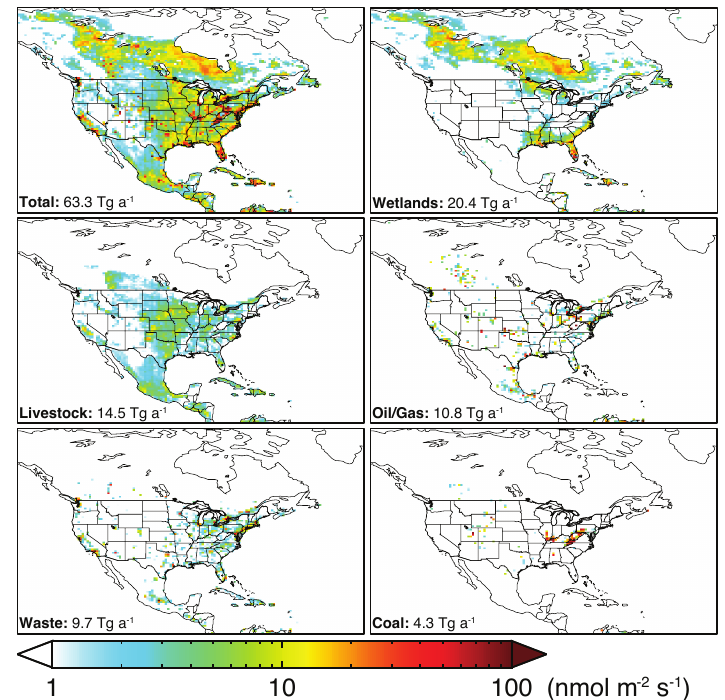
Figure A2. Same as Fig. A1 but for North America with 1/2 ◦ × 2/3 ◦